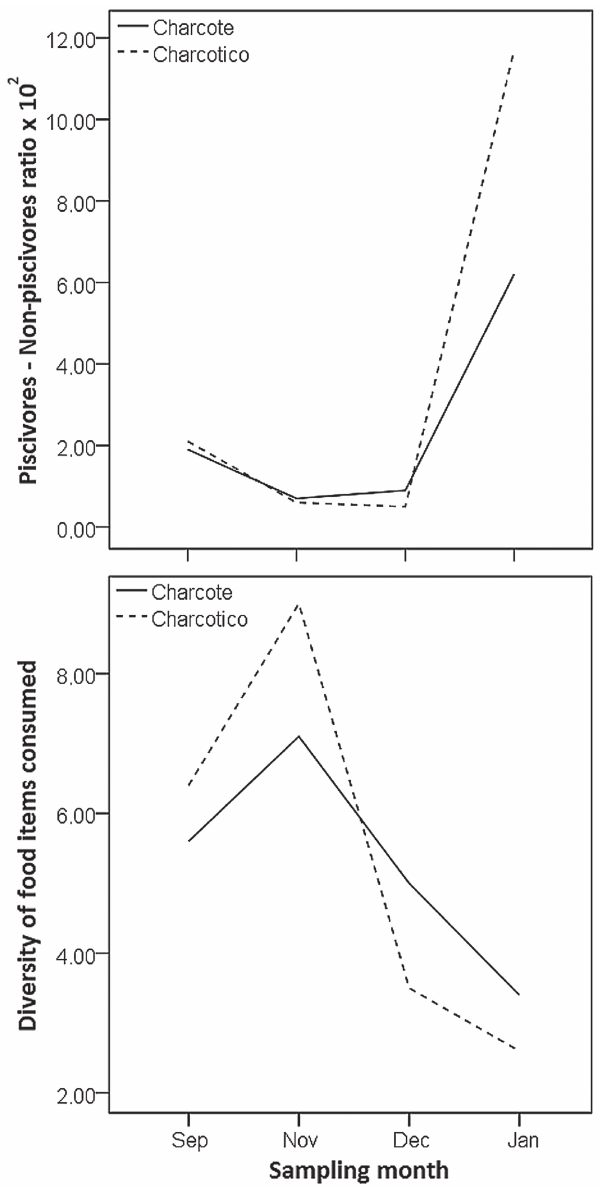
Fig. 3. Seasonal variation in the piscivore to non-piscivore ratio (above) and diversity of food items consumed by fishes (below) in the Charcote and Charcotico streams. The low-water period is represented by January, high water by September, and falling water by November and December. Average interspecific dietary overlap increased as water levels dropped over time in Charcote, but revealed less seasonal variation in Charcotico (Tab. 2). Thus, these results did not corroborate our hypothesis that dietary overlap is lowest during the low-water period. Based on comparisons with null model simulations, average observed dietary overlap indicated significant dietary segregation among fishes in both streams during all periods (Tab. 2;